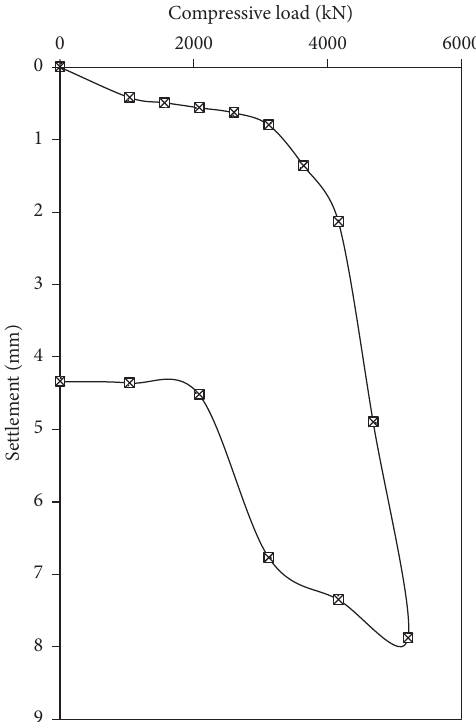
Figure 9: Q-s curves of the tested piles.